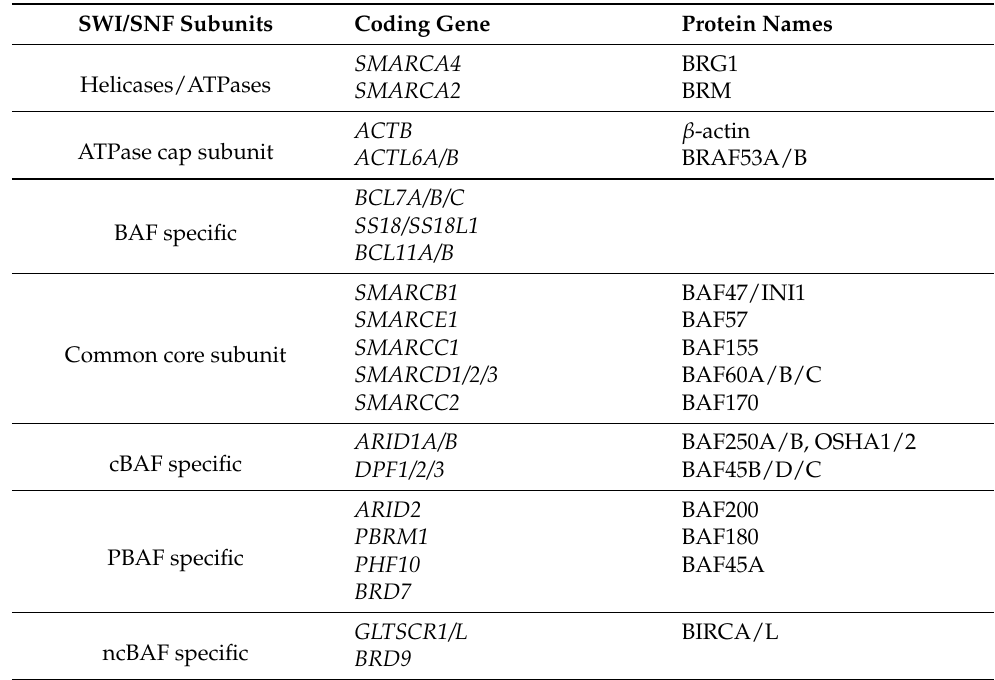
Table 1. SWI/SNF main subunits and coding